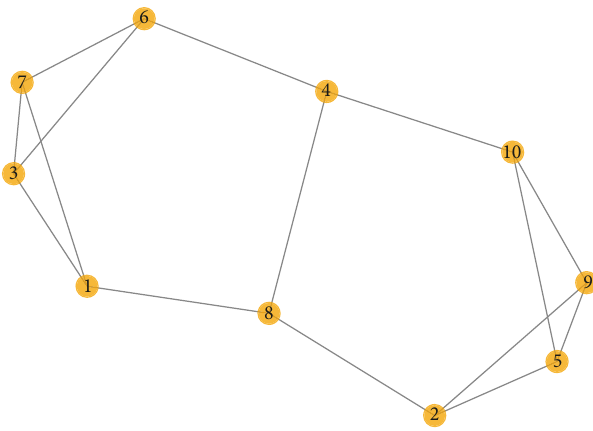
Figure 1: Three-regular graph with 10